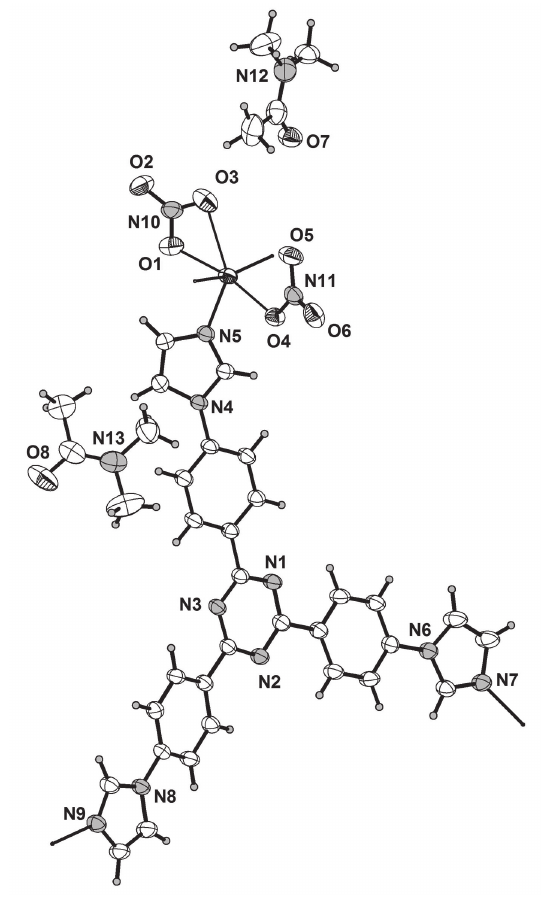
figure. Table 1 contains crystallographic data and Table 2 con-